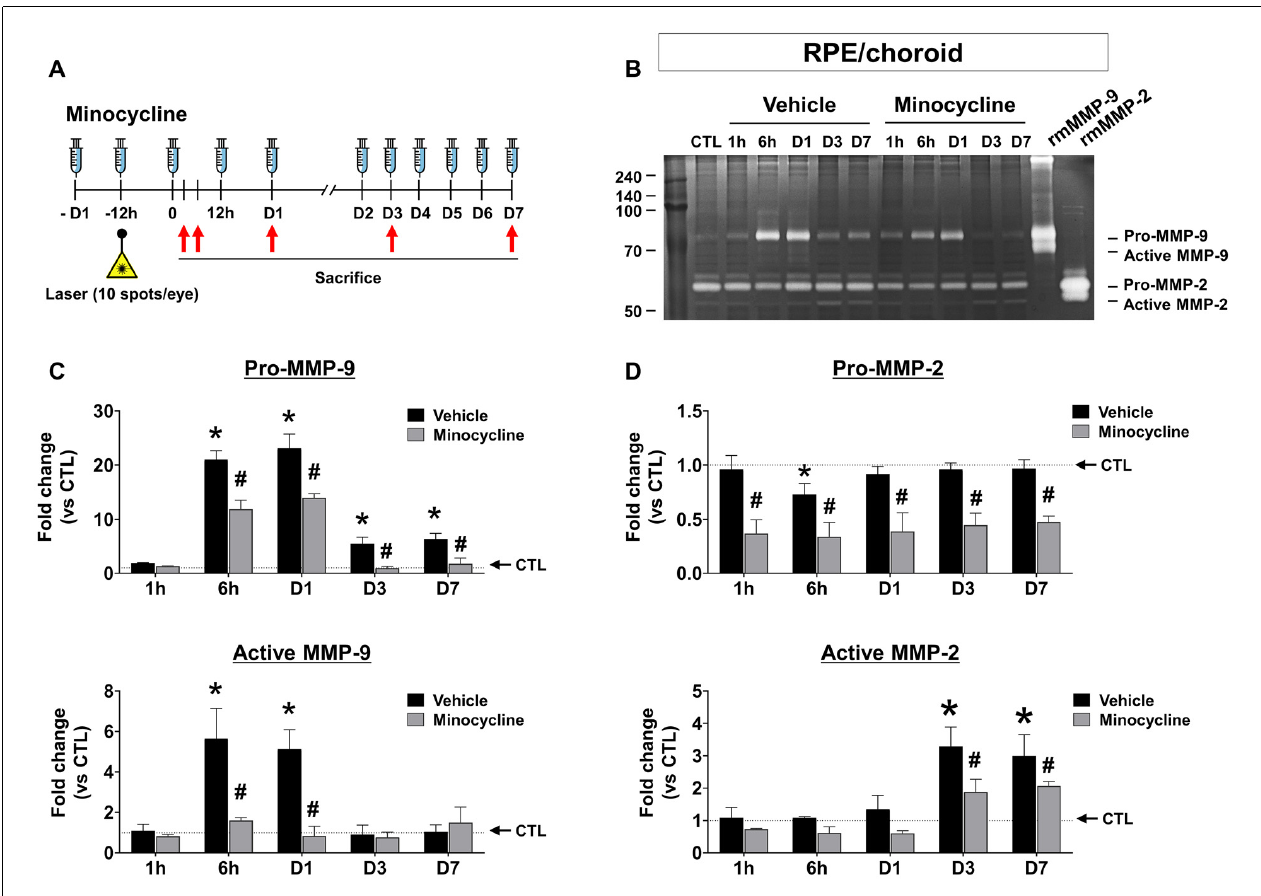
FIGURE 2 | Time-dependent changes of MMP activity and effect of minocycline on MMP activity inretinal pigment epithelium (RPE)/choroid tissues from laser-induced choroidal neovascularization (CNV) mice. (A) Experimental design of minocycline injection and induction of CNV with laser photocoagulation. (B) Representative image of gelatin zymography to visualize RPE/choroid MMP activity. Lane CTL, non-CNV control; 1 h, 6 h, D1, D3, and D7 after CNV induction. (C) Quantification of gelatin zymography of pro-and active MMP-9 in panel (B) . Enzymatic activity was measured by band intensity. (D) Quantification of gelatin zymography of pro-and active MMP-2 in panel (B) . Data are expressed as mean ± SEM. * P < 0.05 vs. CTL; # P < 0.05 vs. Vehicle. n = 6